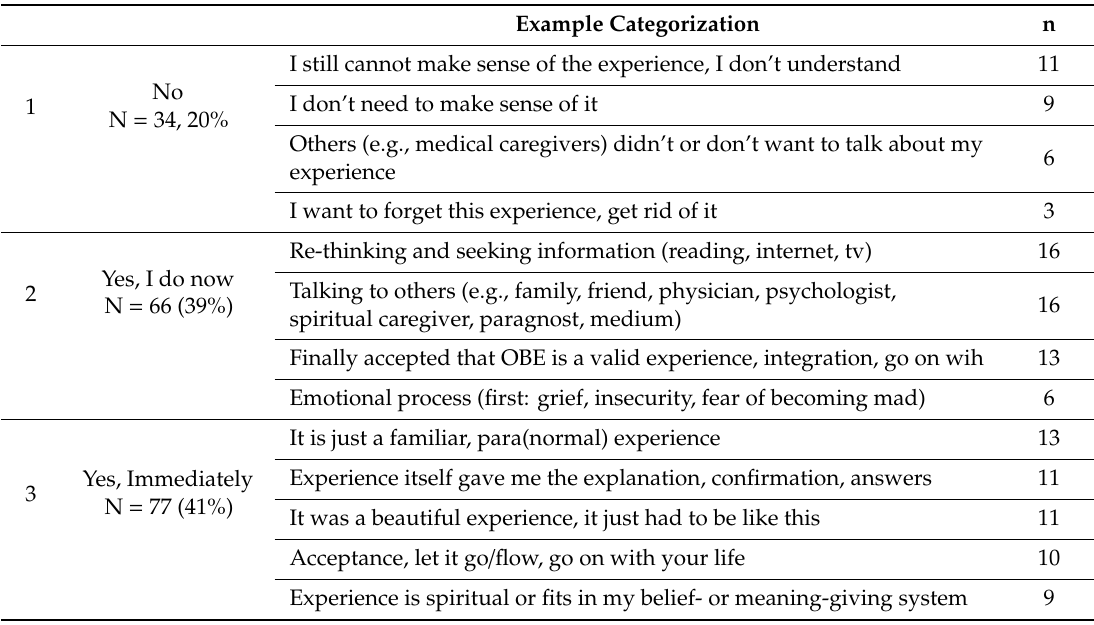
Table 3. Did you make sense of your OBE? How / why (not)? (n = 171) *. Example Categorization n